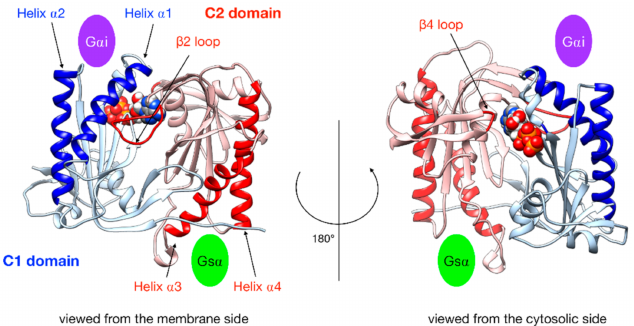
Figure 3. Illustration of the key regions of AC5 catalytic domain structure with bound ATP. The C1 domain is colored blue and the C2 domain is in red, with relevant parts in darker color: the helices of C2 are involved in the binding of the stimulatory protein Gs α , the helices of C1 are involved in the binding of the inhibitory protein G α i, the β 2 loop of C2 ( left side ), and the β 4 loop of C2 ( right side ), which bears the catalytic Lysine residue. The green oval indicates the binding site of Gs α , and the purple oval indicates the binding site of G α